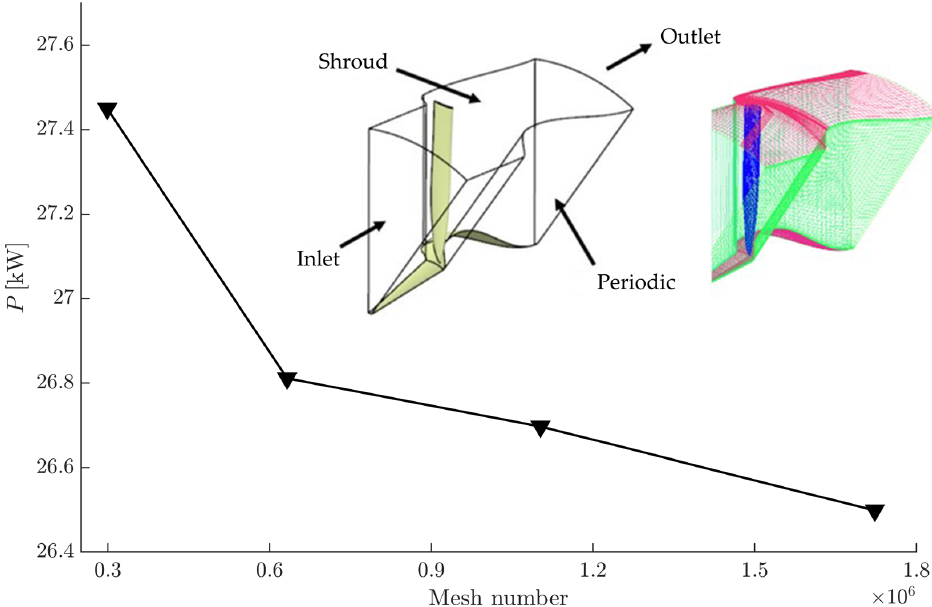
Figure 6. The mesh independence study of 1/10th of the fan disc containing a single blade.